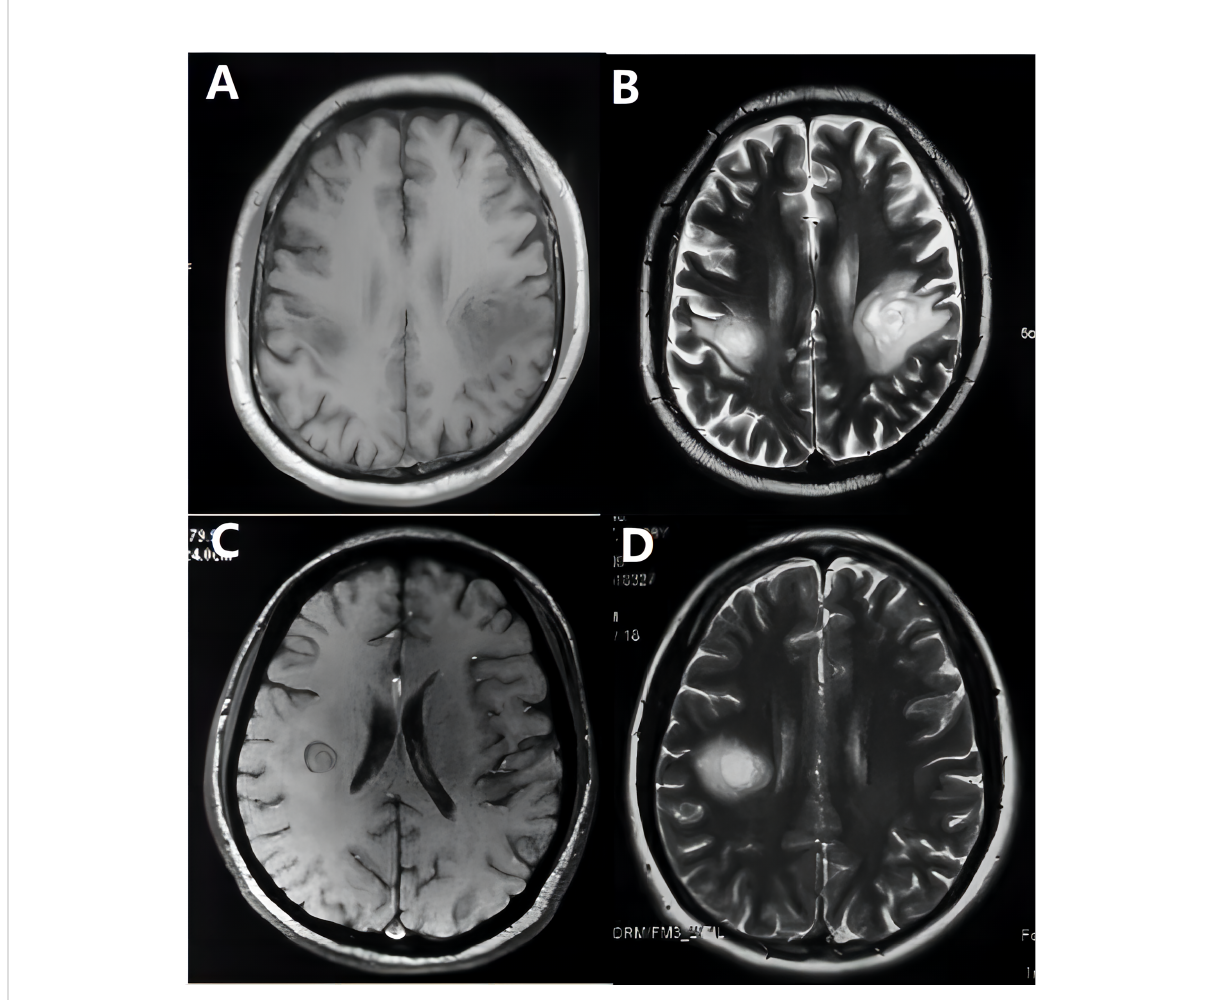
FIGURE 4 Balo images on T1-weighted (A, C) and T2-weighted (B, D) MRI of two